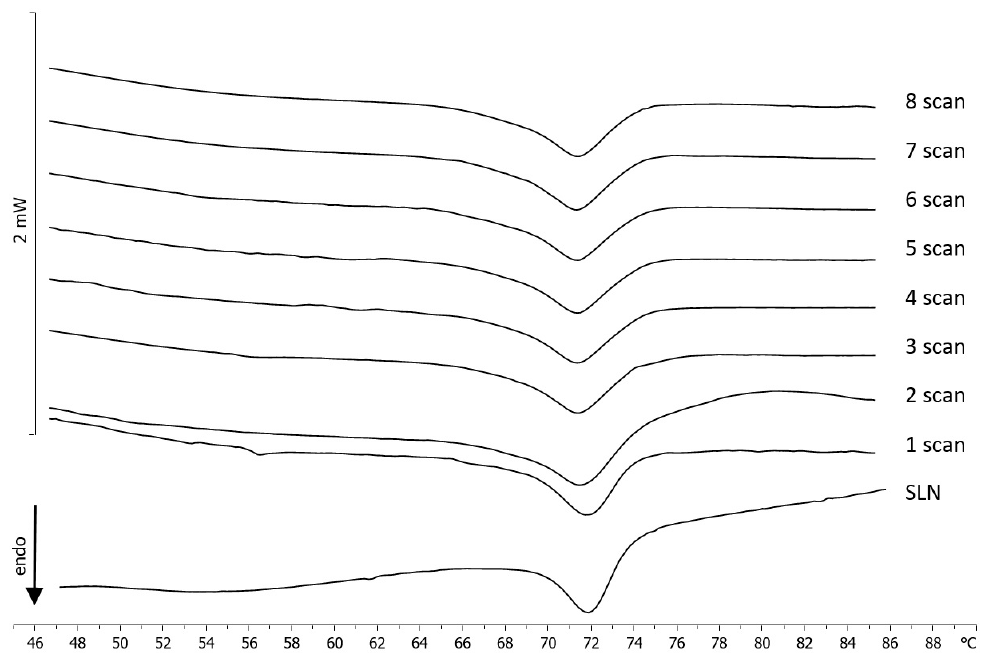
Figure 8. Calorimetric curves, in heating mode, of SLNs left in contact with PEG (1:0.5), at increasing incubation times.